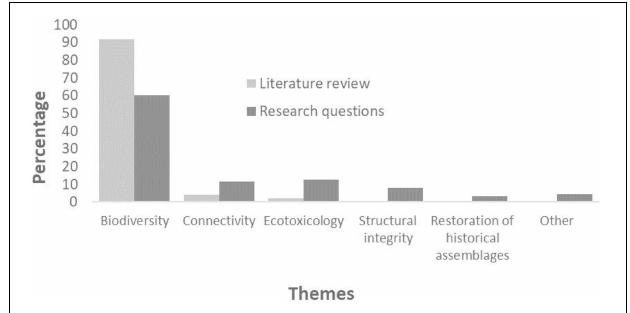
FIGURE 1 | Prevalence of common ecological research themes in global peer-reviewed publications and priority research questions formulated by experts (Fowler et al., 2019) and Australian stakeholders (Shaw et al., 2018).